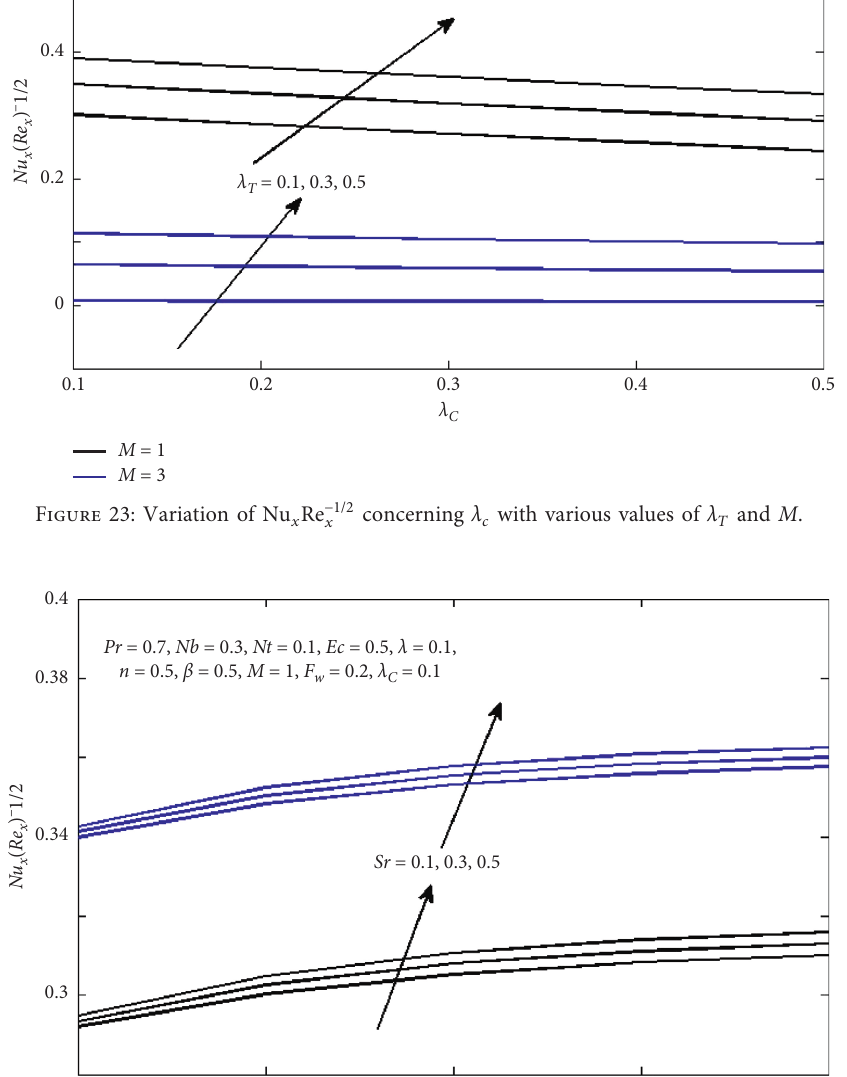
− 1/2 x Re x concerning Lewith number various values of λ T and